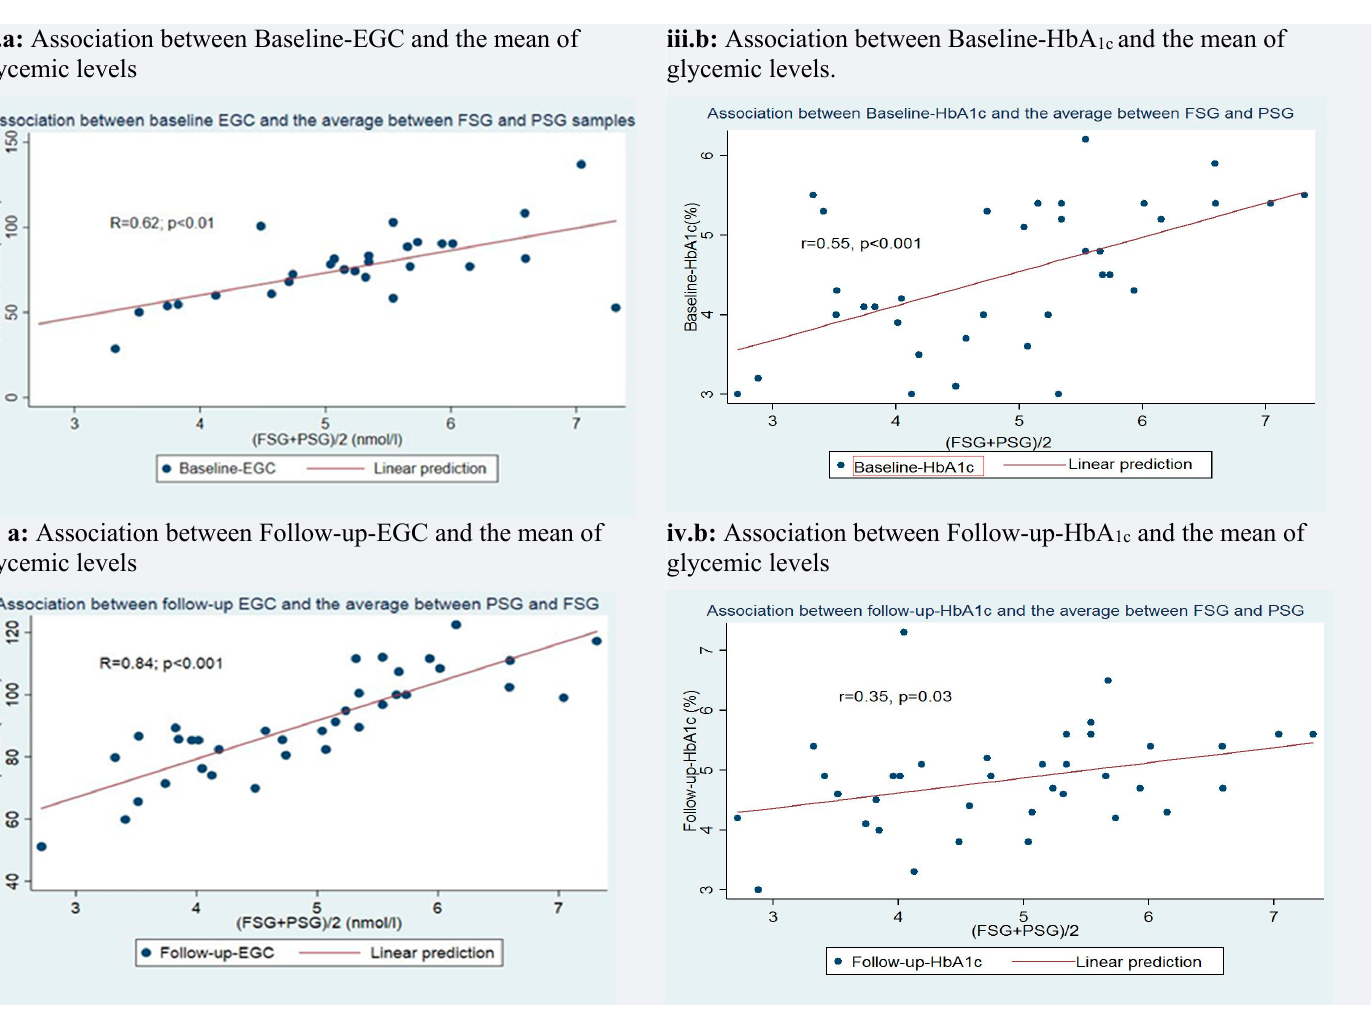
Figure 1. Figures ( a ) of the left side: EGC correlations with FSG and PSG samples at the baseline ( i ) and follow-up ( ii ) visits. Figures ( b ) of the right side: HbA 1c correlations with FSG and PSG samples at the baseline ( i ) and follow-up ( ii ) visits. Figures ( iii ): Chronic glycemia correlations with the baseline EGC ( a )